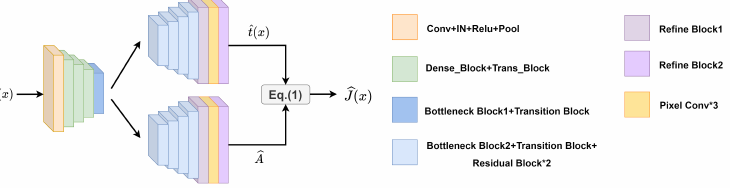
Figure 2. Generator. Learning to estimate parameters t ( x ) and A through densely connected